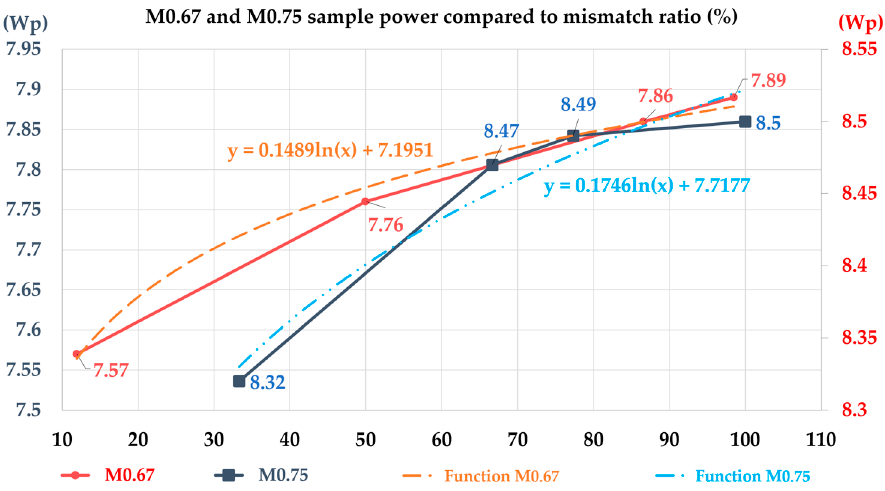
Figure 13. Power output of the M0.67 and M0.75 compared to the electrical mismatch ratio. The output graph for the mismatch combinations of M0.67 also shows the pattern quite clearly. Figure 13 shows that the slope of the output increases up to 50% mismatch ratio range and the output slope over the 50% range are significantly different. This means that the pattern that the cell’s electrical mismatch affects the output changes around 50%.